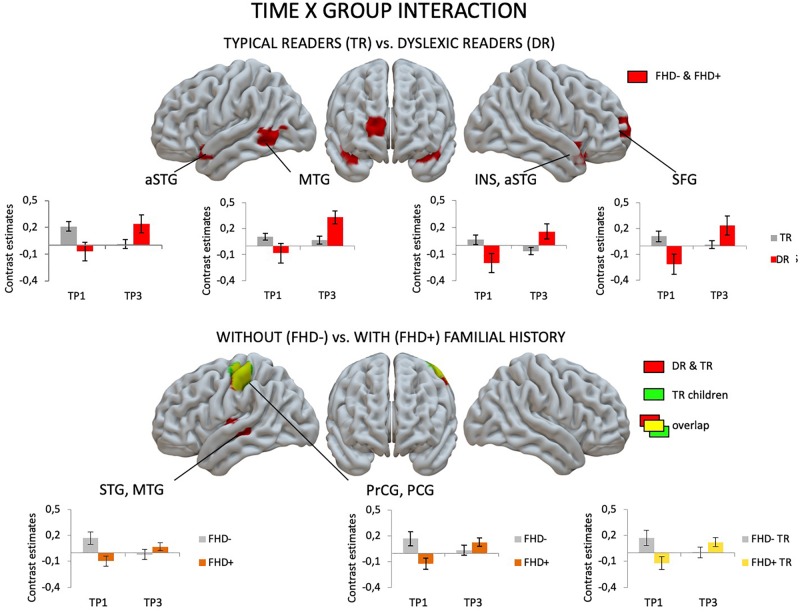
Effects of group (children with dyslexia vs. typical readers; children with a familial history of dyslexia vs. children without a familial history of dyslexia) and time (the first vs. the third time point) interaction as revealed in flexible factorial design.